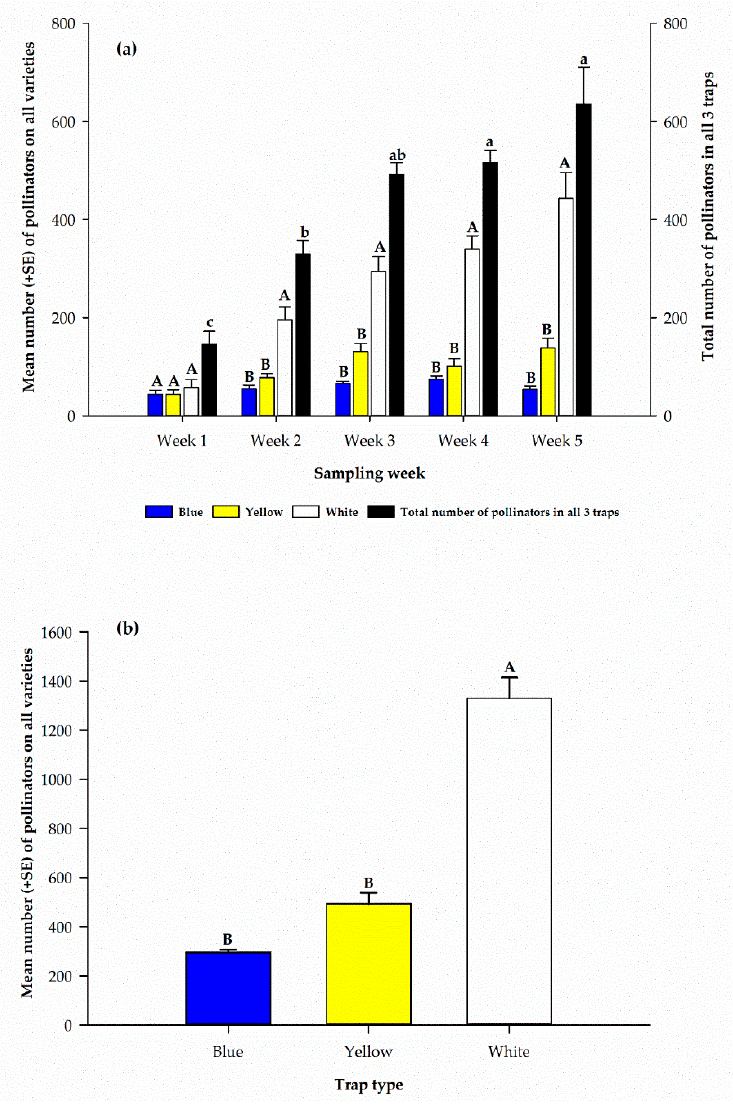
Figure 2. ( a ) Weekly distribution of pollinators in three different color pan traps. ( b ) Total number of pollinators captured in three different traps on cowpea varieties over the five sampling weeks. In ( a ), upper case letters are used to compare different color trap means within each week. Lower case letters are used to compare the combined trap means across all weeks. Mean numbers with the same letters are not significantly different ( p > 0.05).